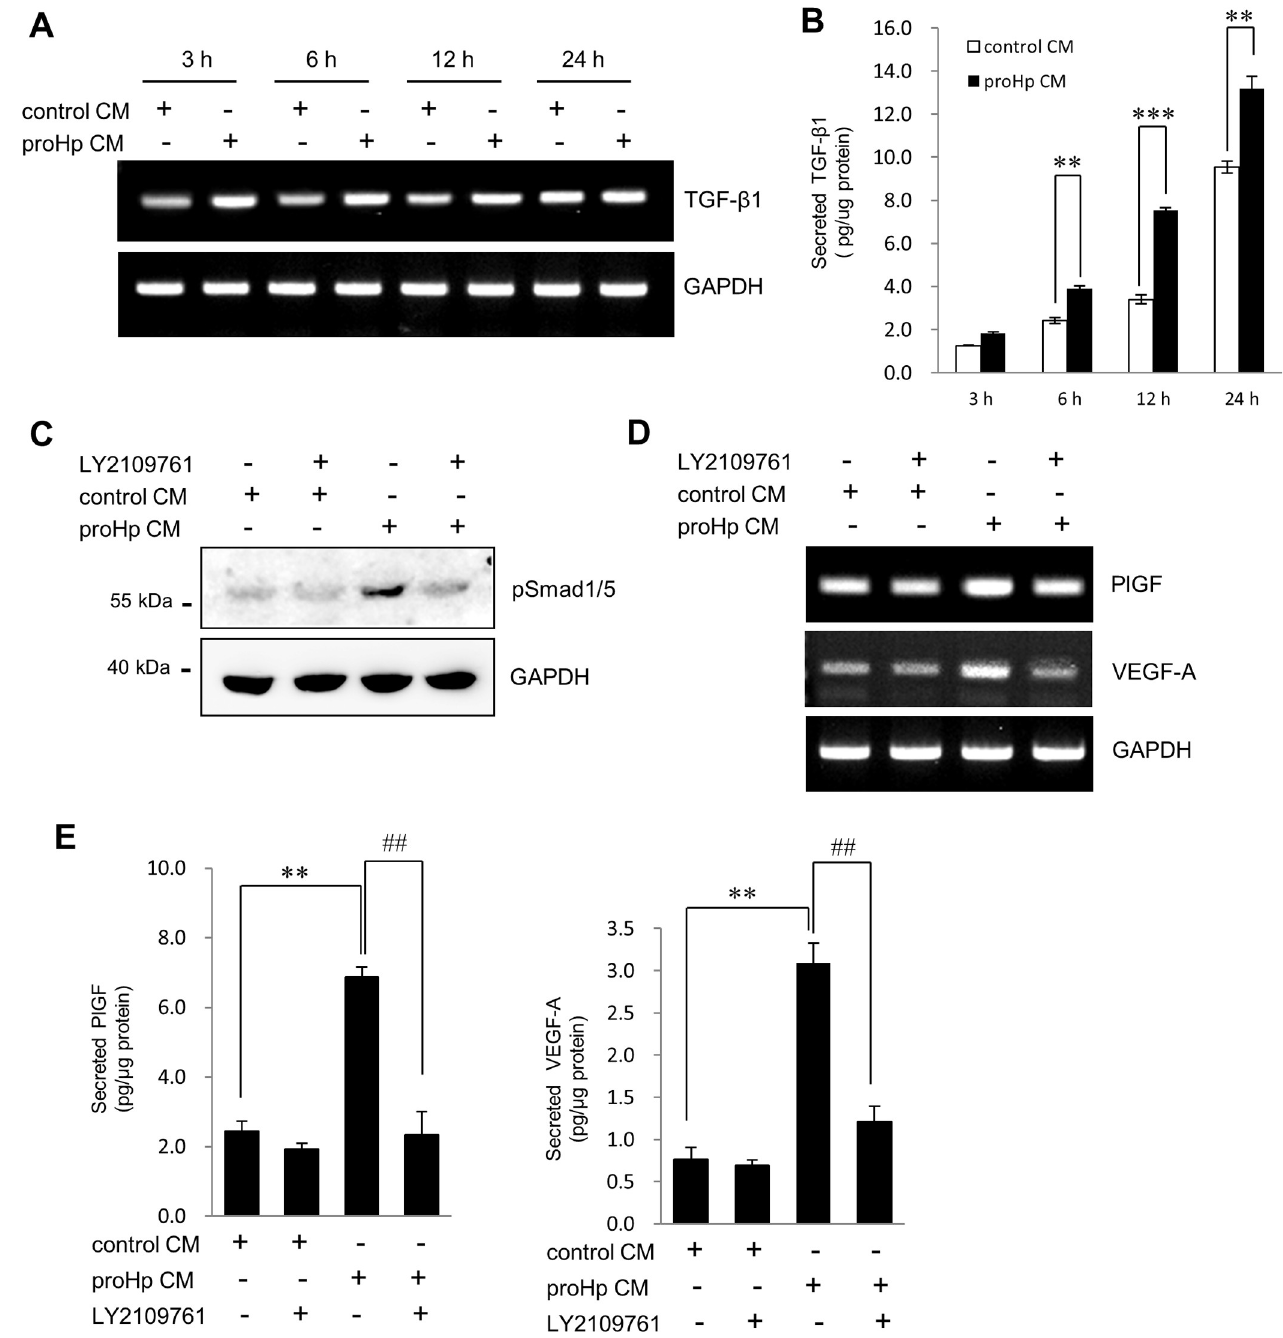
Fig 5. Involvement of TGF- β 1 signaling in proHp-induced PlGF and VEGF-A expression. (A and B) After HUVECs were serum-starved for 3 h, the cells were treated with control CM or proHp CM (final 0.2 μ g/ml proHp) for the indicated times. TGF- β 1 mRNA levels and secreted protein levels were determined by RT-PCR and ELISA, respectively. �� P < 0.01 and ��� P < 0.001 vs. control CM-treated cells (Student’s t-test). (C) After serum starvation for 3 h, the cells were preincubated for 1 h in the presence or absence of the TGF β R І / ІІ kinase inhibitor LY2109761 (1 μ M). The cells were then further incubated for 6 h in EBM-2 medium containing proHp CM (final 0.2 μ g/ml proHp). Smad1/5 phosphorylation was analyzed by western blot. (D and E) After pretreatment with the inhibitor LY2109761 for 1 h, the cells were incubated for 24 h in EBM-2 medium containing 1% FBS and proHp CM (final 0.2 μ g/ml proHp). The expression of PlGF and VEGF-A was determined, and the data are shown as the mean ± SD of three independent experiments. �� P < 0.01 vs. control CM-treated cells, ## P < 0.01 vs. no inhibitor treatment (Student’s t-test).